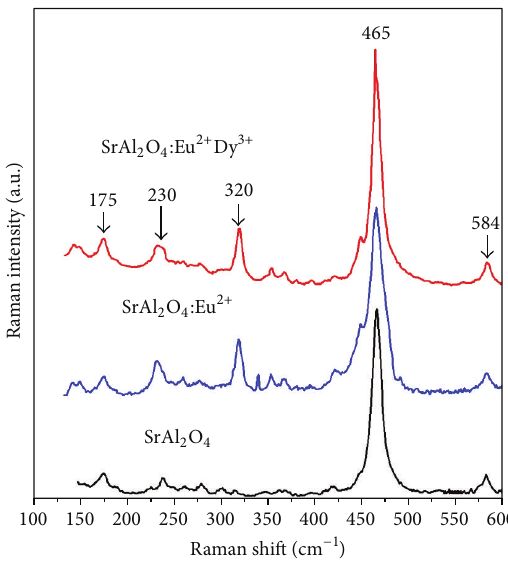
Figure15:ResultsofRamanspectroscopyforSrAl 2 O 4 NPsundoped (black curve), doped with Eu 2+ (blue curve), and codoped with Eu 2+ and Dy 3+ , under excitation by 633 nm laser